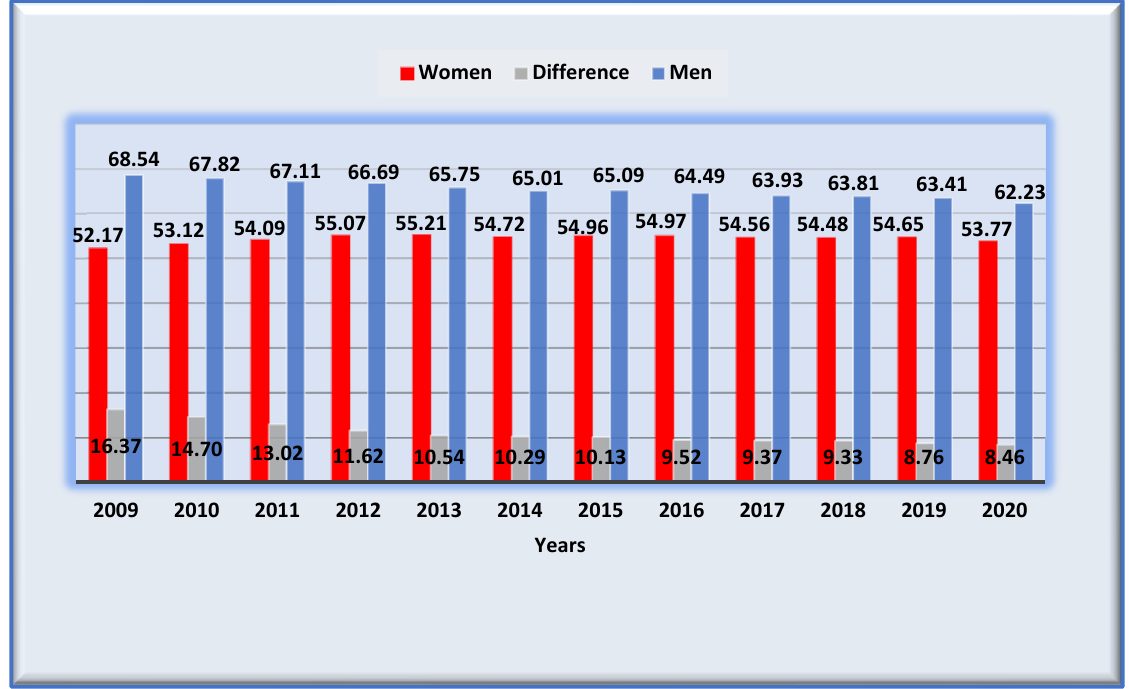
Figure 3. Activity rates of married people by sex (percentages). Source: Authors with data from the Statistics National Institute ( Instituto Nacional de Estadística ).